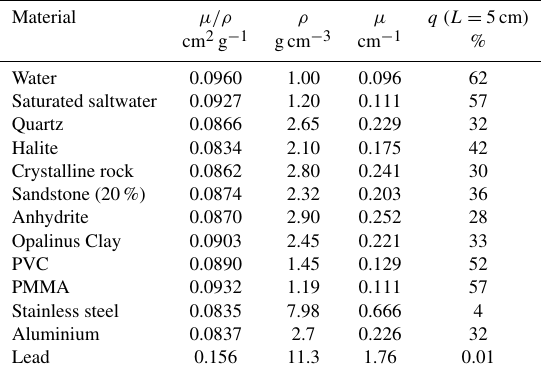
Table 2. Attenuation properties at 511keV of relevant materials ( µ/ρ : mass attenuation coefficient, ρ : density, µ : linear attenuation coefficient, q : intensity through material thickness of 5cm). Data assembled from the XCOM database (Berger et al.,